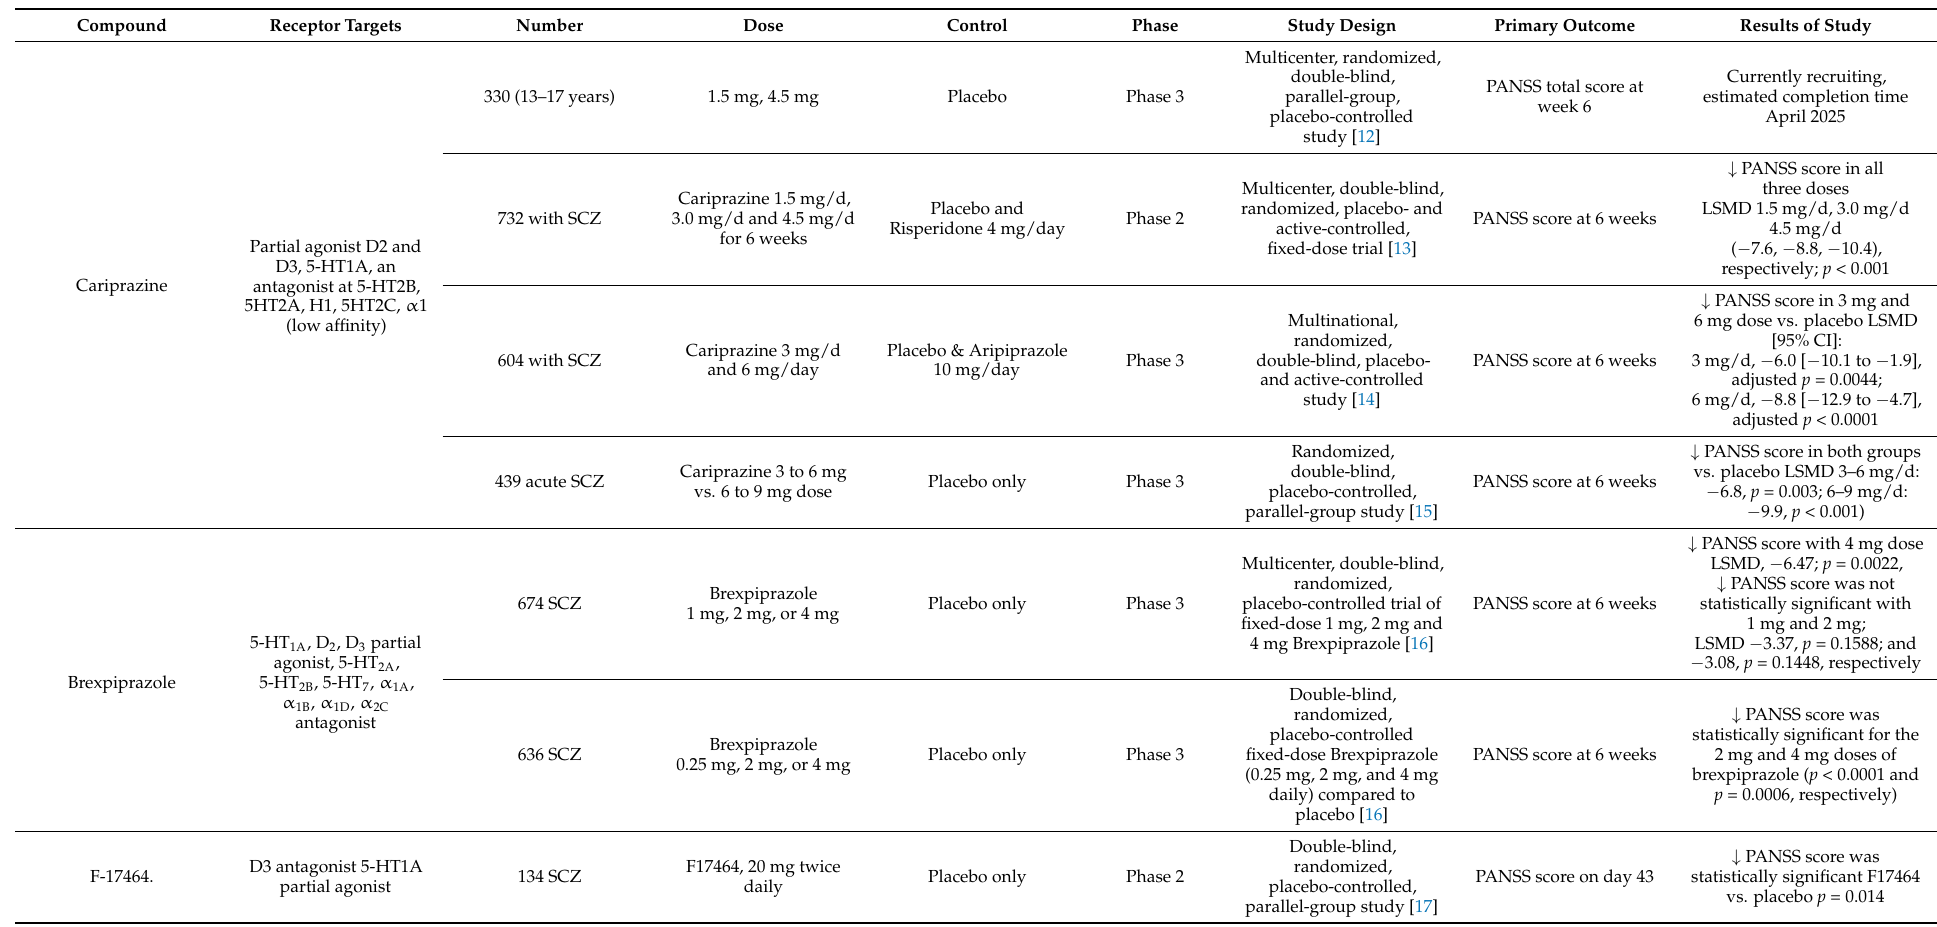
Table 1. Modulators Predominantly Affecting Dopaminergic